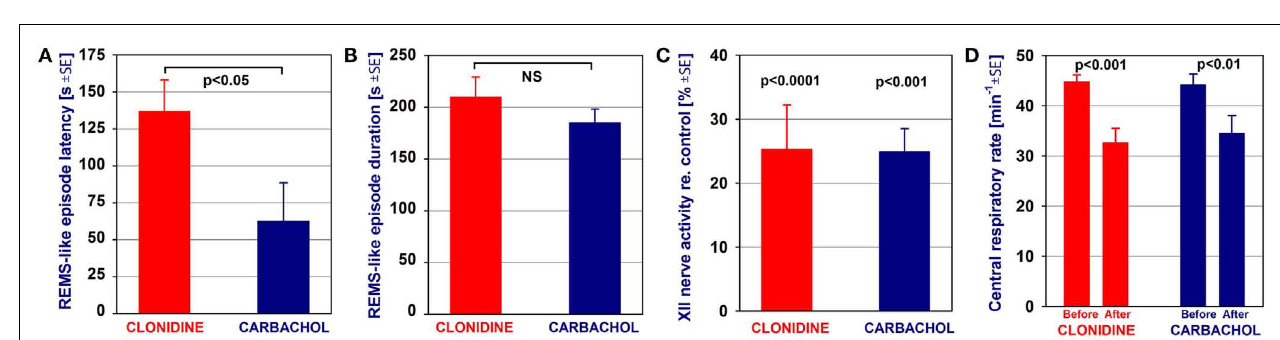
FIGURE 5 |A REM sleep-like episode triggered after clonidine was injected into theA5 regions bilaterally and then into the right LC. The injection marker shows the LC injection only.Trace labels and figure format are the same as for Figure 3 . Note the similarity of the changes